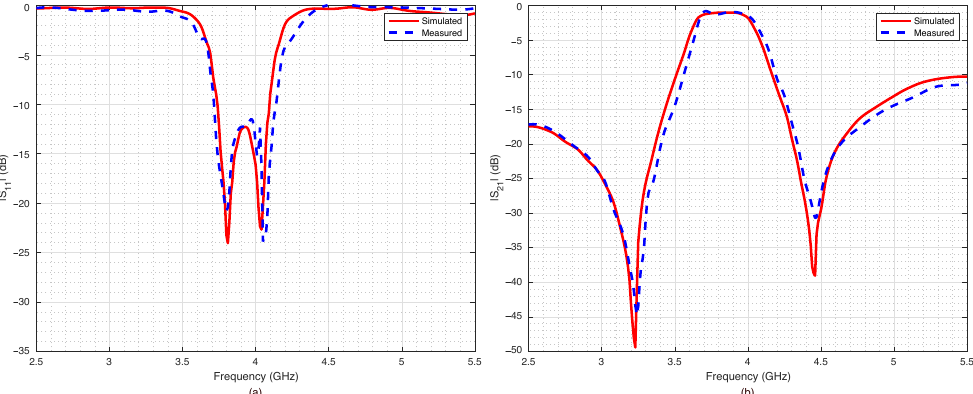
Figure 14. Simulated vs. measured scattering parameters of the pseudohairpin filter prototype: ( a ) return loss S 11 , ( b ) insertion loss S 21 . RF-MEMS switches configuration 000 (all